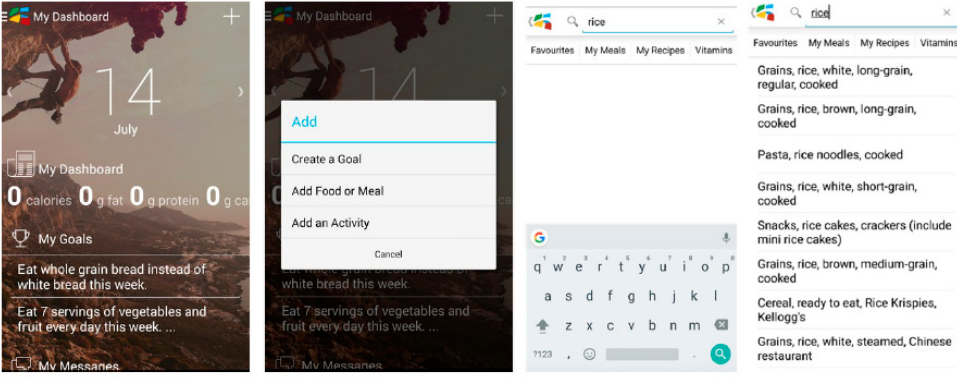
Figure 1. eaTracker ® mobile app screenshots.